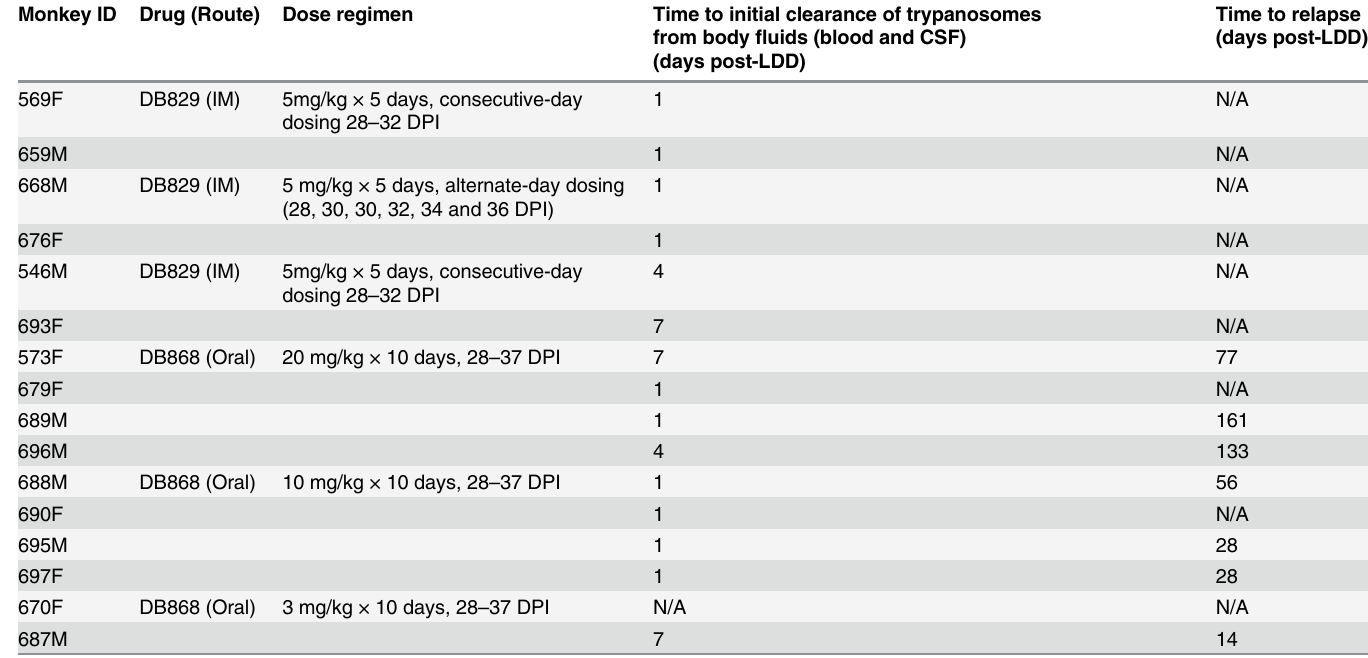
Key: F, female; M, male; IM, intramuscular; DPI, days post-infection; CSF, cerebrospinal fl uid; LDD, last drug dose; N/A, not applicable (monkey did not